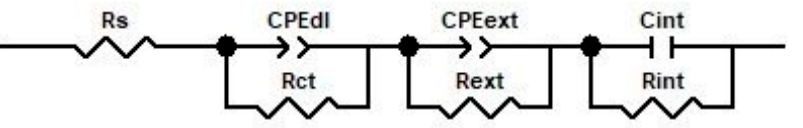
Figure 7. Model for the equivalent electrical circuits proposed for fitting the experimental impedance spectra. Table 4. The values of equivalent electrical circuits elements for unoxidized and oxidized samples for different periods in water at 550 ◦ C and 250